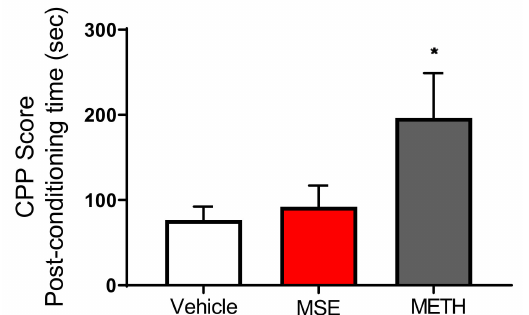
Figure 9. Effects of Maydis stigma extracts on place preference in mice. Each bar represents the mean ± S.E.M. of the difference in the time spent in the MSE-, METH-, or Veh-paired compartment during the post- and preconditioning phases of the CPP (N = 10). * p < 0.05 vs. Veh. 2.8. MS Extracts Inhibited the H 2 O 2 -Induced Neuronal Cell Death in Rat Cortical Neurons